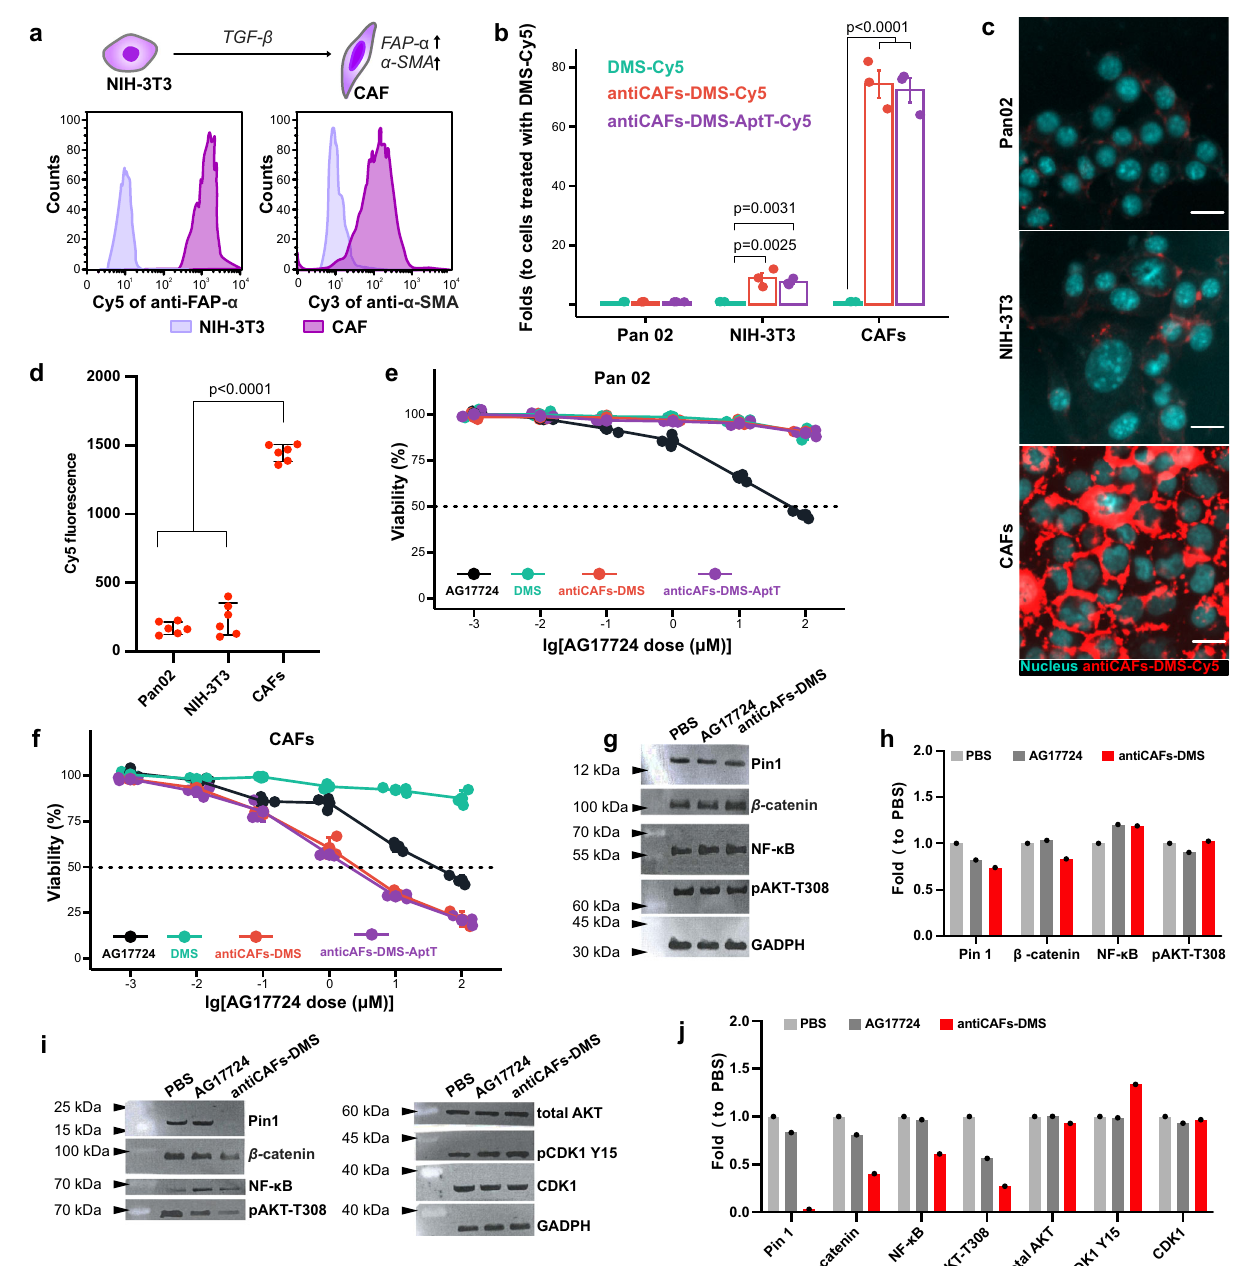
Fig. 3 | Speci fi c Pin1 inhibition in CAFs achieved by antibody modi fi ed DMS invitro.a EstablishmentandvalidationofCAFsviahighexpressionsofbothFAP- α and α -SMA. b Cellular uptake of Cy5-labeled formulations on Pan02 cells, NIH-3T3 cells, and CAFs, measured by fl ow cytometry ( n =3 biologically independent experiments; error bars, mean±SD). c Cellular uptake of Cy5-labeled antiCAFs- DMS on cells, imaged by fl uorescent microscopy. Scale bars are 20 μ m. Three independent repetitions got similar results. d Cellular uptake of Cy5-labeled antiCAFs-DMS on cells, quanti fi ed by fl ow cytometry ( n =6 biologically indepen- dent samples; error bars, mean±SD). Cytotoxicity on Pan02 cells ( e ) and CAFs ( f ) ( n =3 biologically independent experiments; error bars, mean±SD). g Western